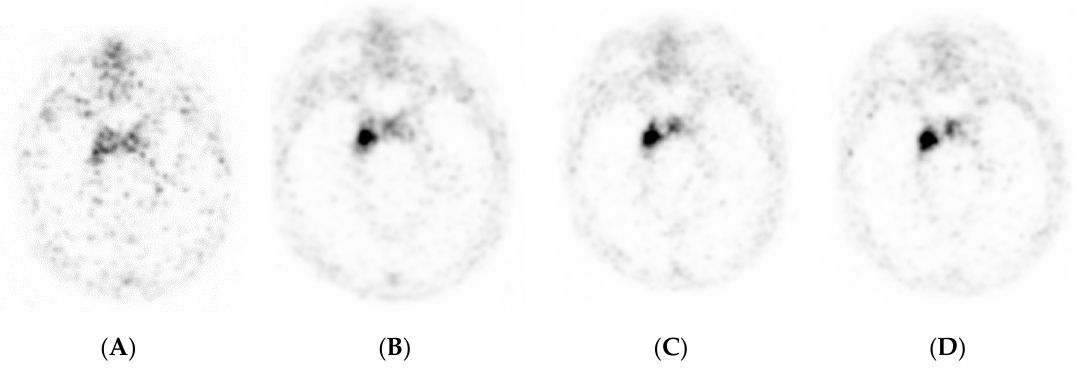
Figure 1. Dynamic PET images of meningioma: ( A ) 1 min (min) post tracer injection (p.i.); ( B ) 5 min p.i.; ( C ) 15 min p.i.; ( D ) 60 min p.i.